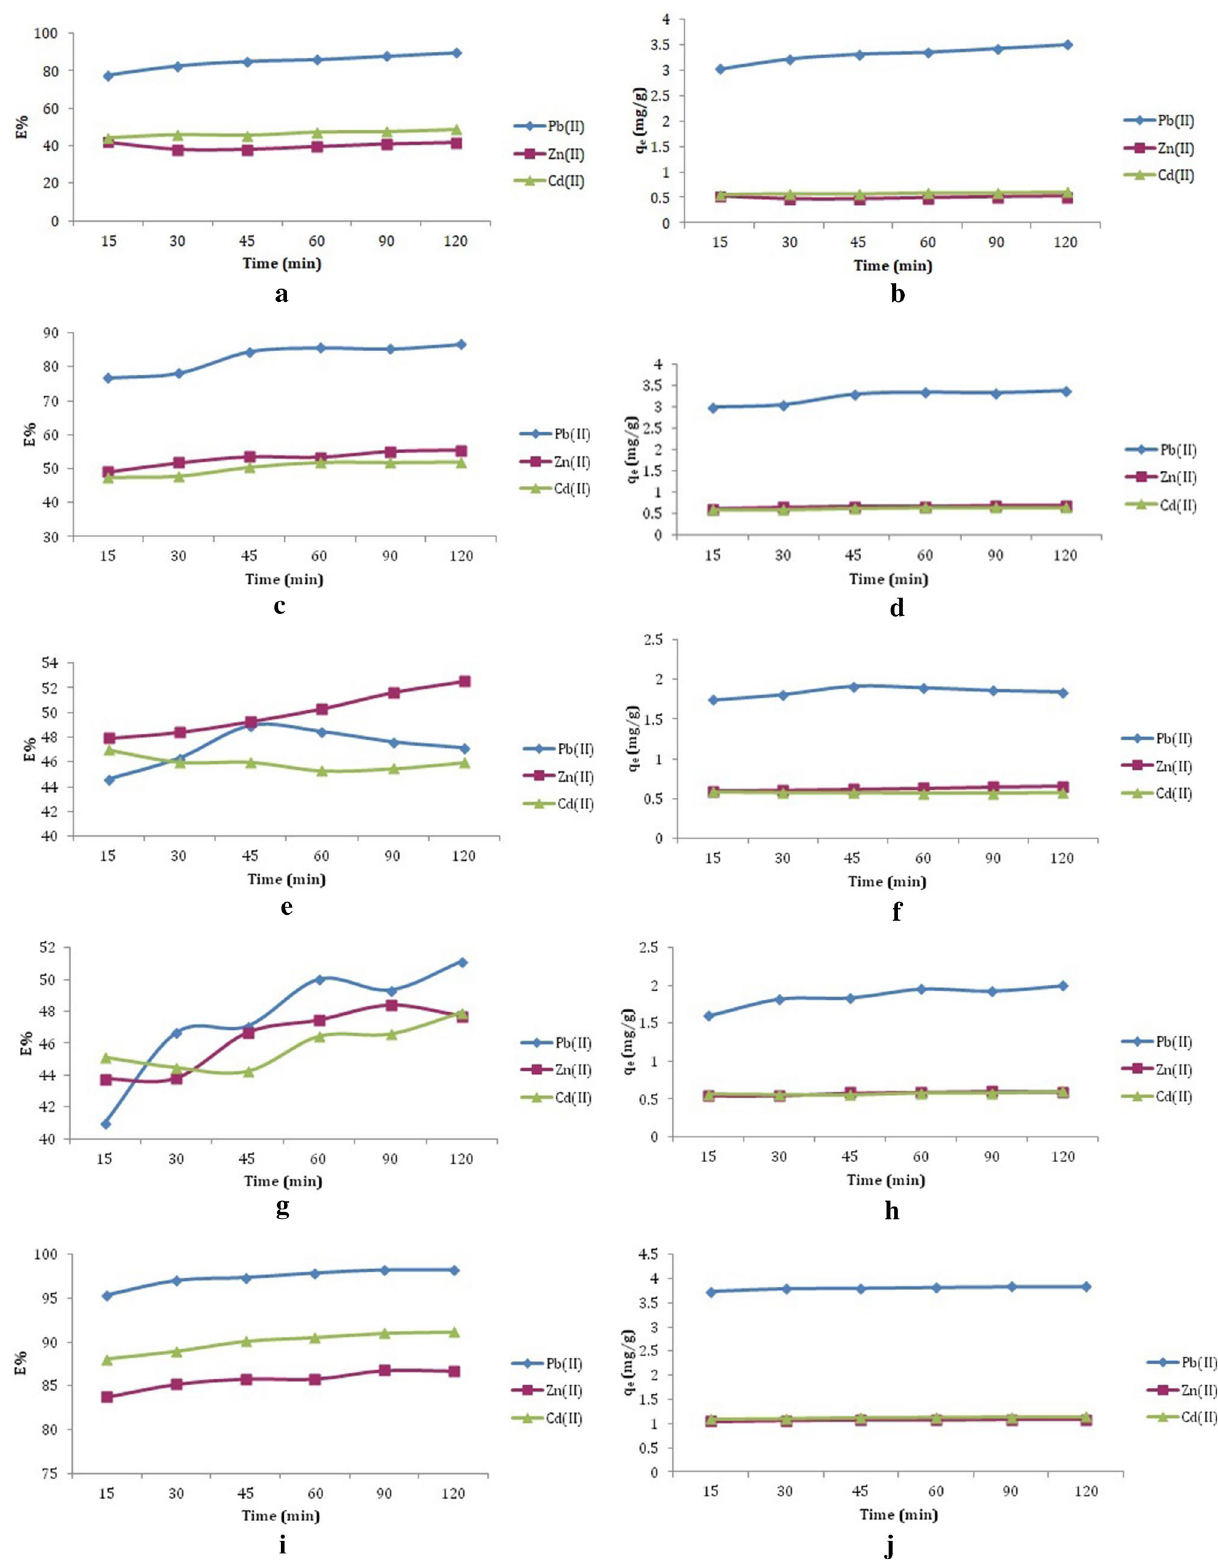
Figure 2. The contact time as a function of the ( a ) removal efficiency (E%) of Pb(II), Zn(II) and Cd(II) ions by ZSC–H 2 SO 4 ; ( b ) the amount of biosorbed Pb(II), Zn(II) and Cd(II) ions per gram of ZSC–H 2 SO 4 ; ( c ) the removal efficiency (E%) of Pb(II), Zn(II) and Cd(II) ions by ZSC–citric acid; ( d ) the amount of biosorbed Pb(II), Zn(II) and Cd(II) ions per gram of ZSC–citric acid; ( e ) the removal efficiency(E%) of Pb(II), Zn(II) and Cd(II) ions by ZSC–HCl; ( f ) the amount of biosorbed Pb(II), Zn(II) and Cd(II) ions per gram of ZSC–HCl; ( g ) the removal efficiency (E%) of Pb(II), Zn(II) and Cd(II) ions by ZSC–H 2 O 2 ; ( h ) the amount of biosorbed Pb(II), Zn(II) and Cd(II) ions per gram of ZSC–H 2 O 2 ; ( i ) the removal efficiency(E%) of Pb(II), Zn(II) and Cd(II) ions by ZSC–KOH and ( j ) the amount of biosorbed Pb(II), Zn(II) and Cd(II) ions per gram of